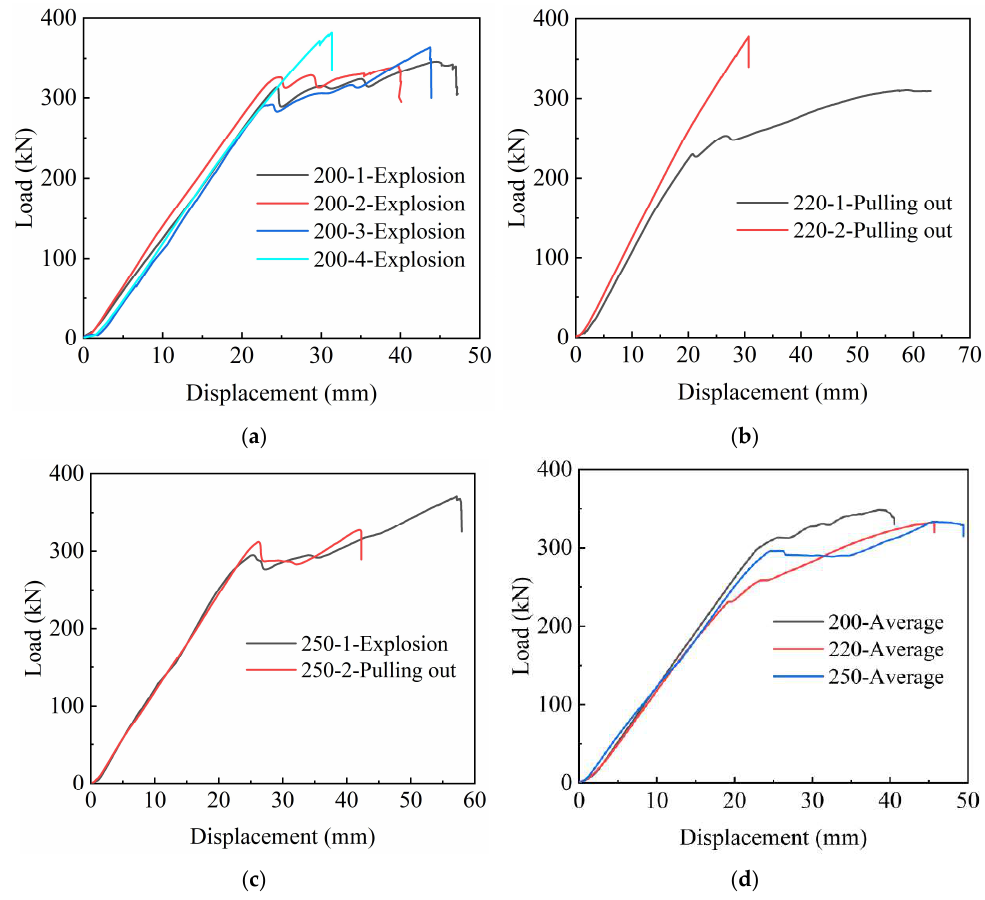
Figure 12. Force-displacement relationship curves of anchor control group. ( a ) Force-displacement curves of 200-X test group; ( b ) force-displacement curves of 220-X test group; ( c ) force-displacement curves of 250-X test group; ( d ) average of force-displacement curves.